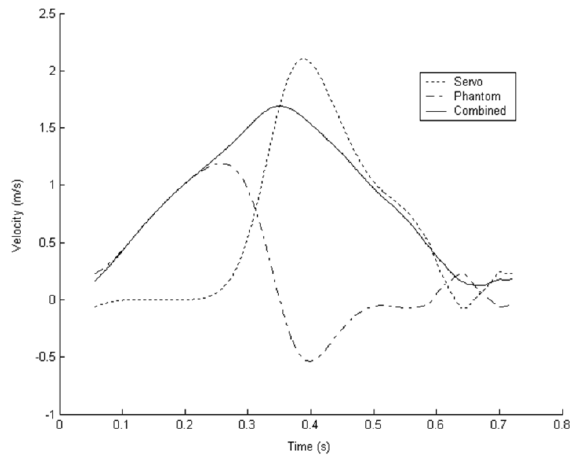
Figure 8. Averaged velocity profile for the reciprocal tapping task. The controller includes a dead-band component.